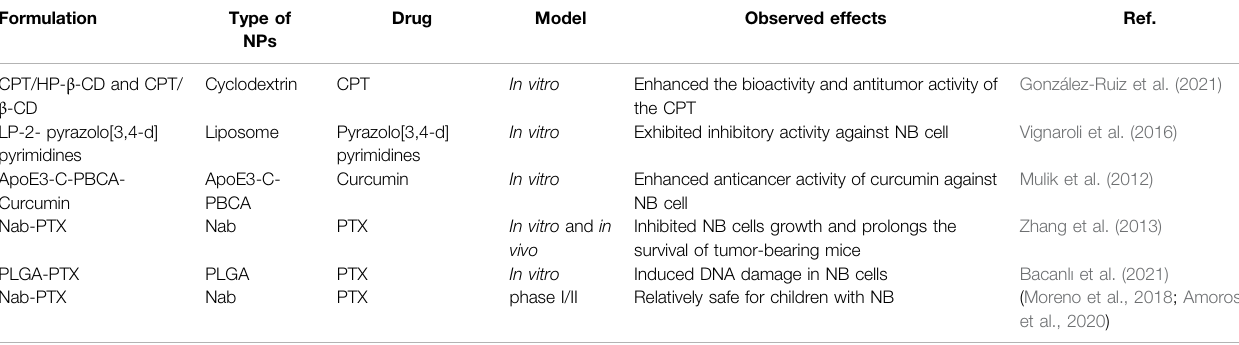
TABLE 2 | Summary of emerging nanomedicines for NB chemotherapy.